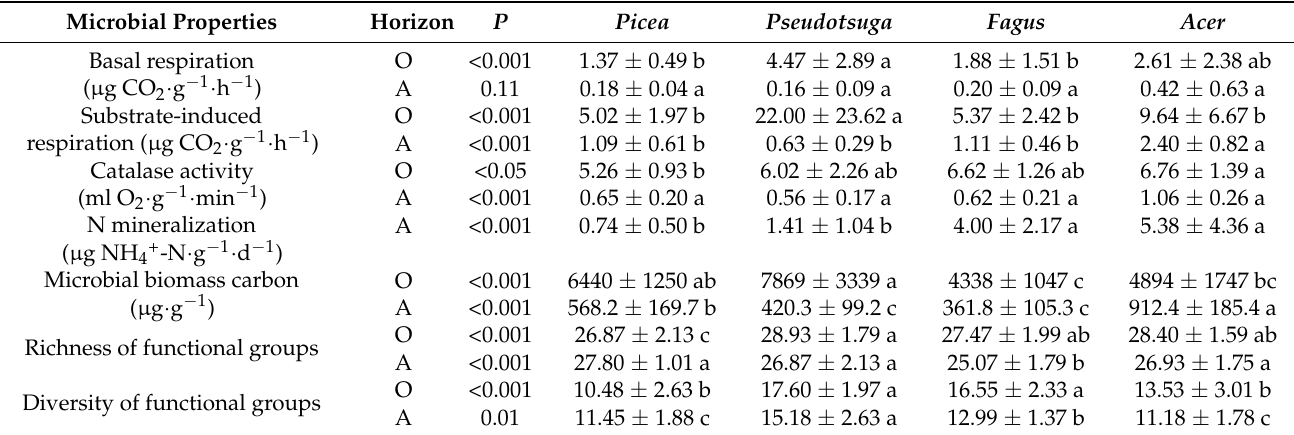
Table 2. Basic statistics (means ± standard deviations) of soil microbial characteristics in stands of different tree species.